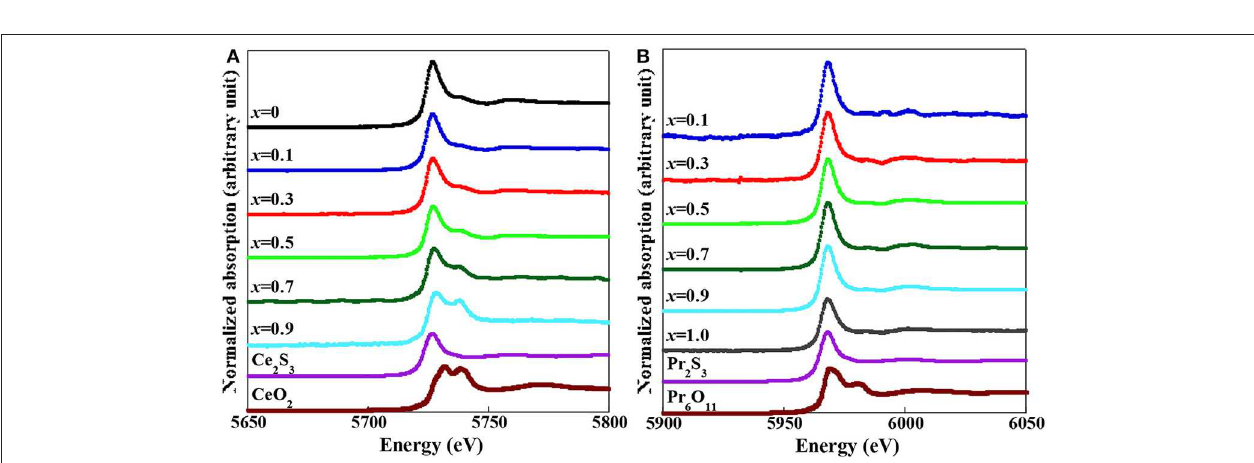
FIGURE 4 | [010]-zone axis HAADF-STEM image and Ce, Pr, Bi, O, S elemental maps of (Ce,Pr)OBiS 2 with x = 0.9 single crystal.